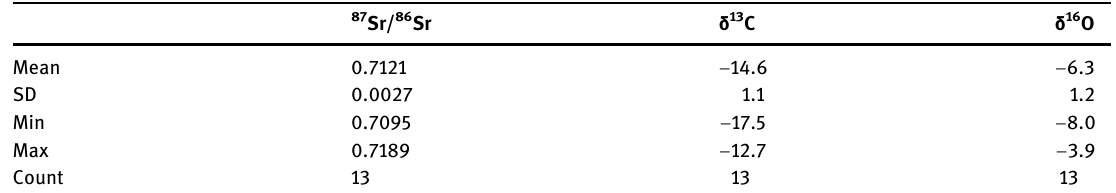
Table 2: Descriptive statistics for isotope ratios from Skateholm tooth beads